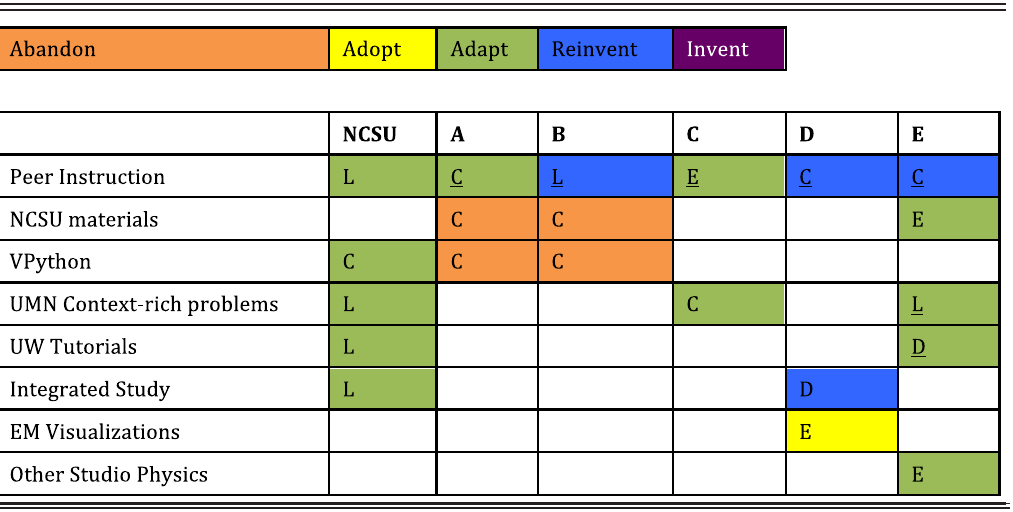
TABLE IV. Composite research-based reforms for SCALE-UP implementation. The letter denotes the source of information: E (educational experience in graduate school, etc.), C (colleague from within or outside the department), and L (literature). Underline indicates that it was preexisting in introductory courses. Color denotes position on adoption-innovation spectrum, as shown in the legend